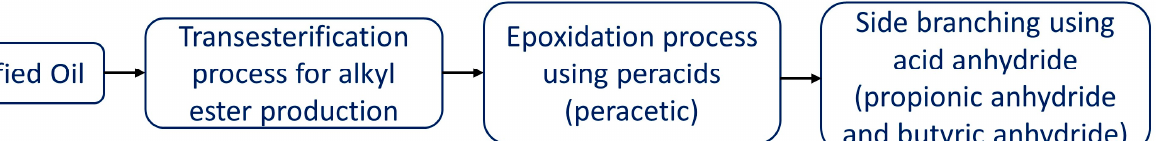
Figure 3. Systematic flow chart of epoxidized and grafted ester.